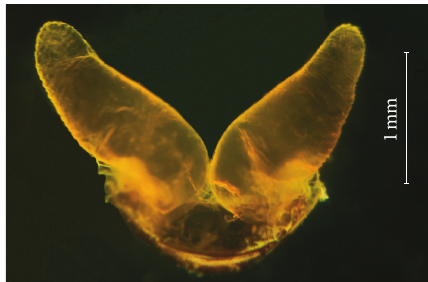
Figure 1: Defensive gland of Mesomorphus villiger cut from the remainder of the sternites.